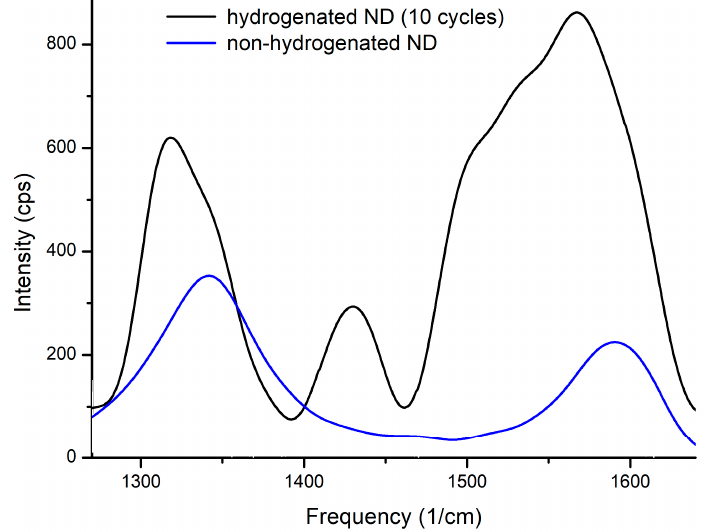
Figure 8. Raman spectroscopy of non-hydrogenated and hydrogenated nanodiamonds.